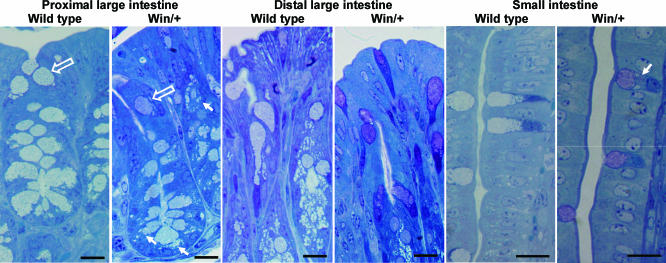
Evidence of Mucin Misfolding in Heterozygous MiceIntestinal tissue from mice heterozygous for the Win mutation (Win/+) was fixed with glutaraldehyde, embedded in resin, and semi-thin sections stained with toluidine blue. Note the variable degree of vacuolisation of the goblet cells in the base of the crypts in the proximal large intestine (solid white arrows) and the lack of/minimal vacuolisation in surface goblet cells in the proximal large intestine (hollow arrows), distal large intestine and small intestinal villi. Tissue from wild-type C57BL6 mice is shown for comparison. Scale bars = 20 μm.